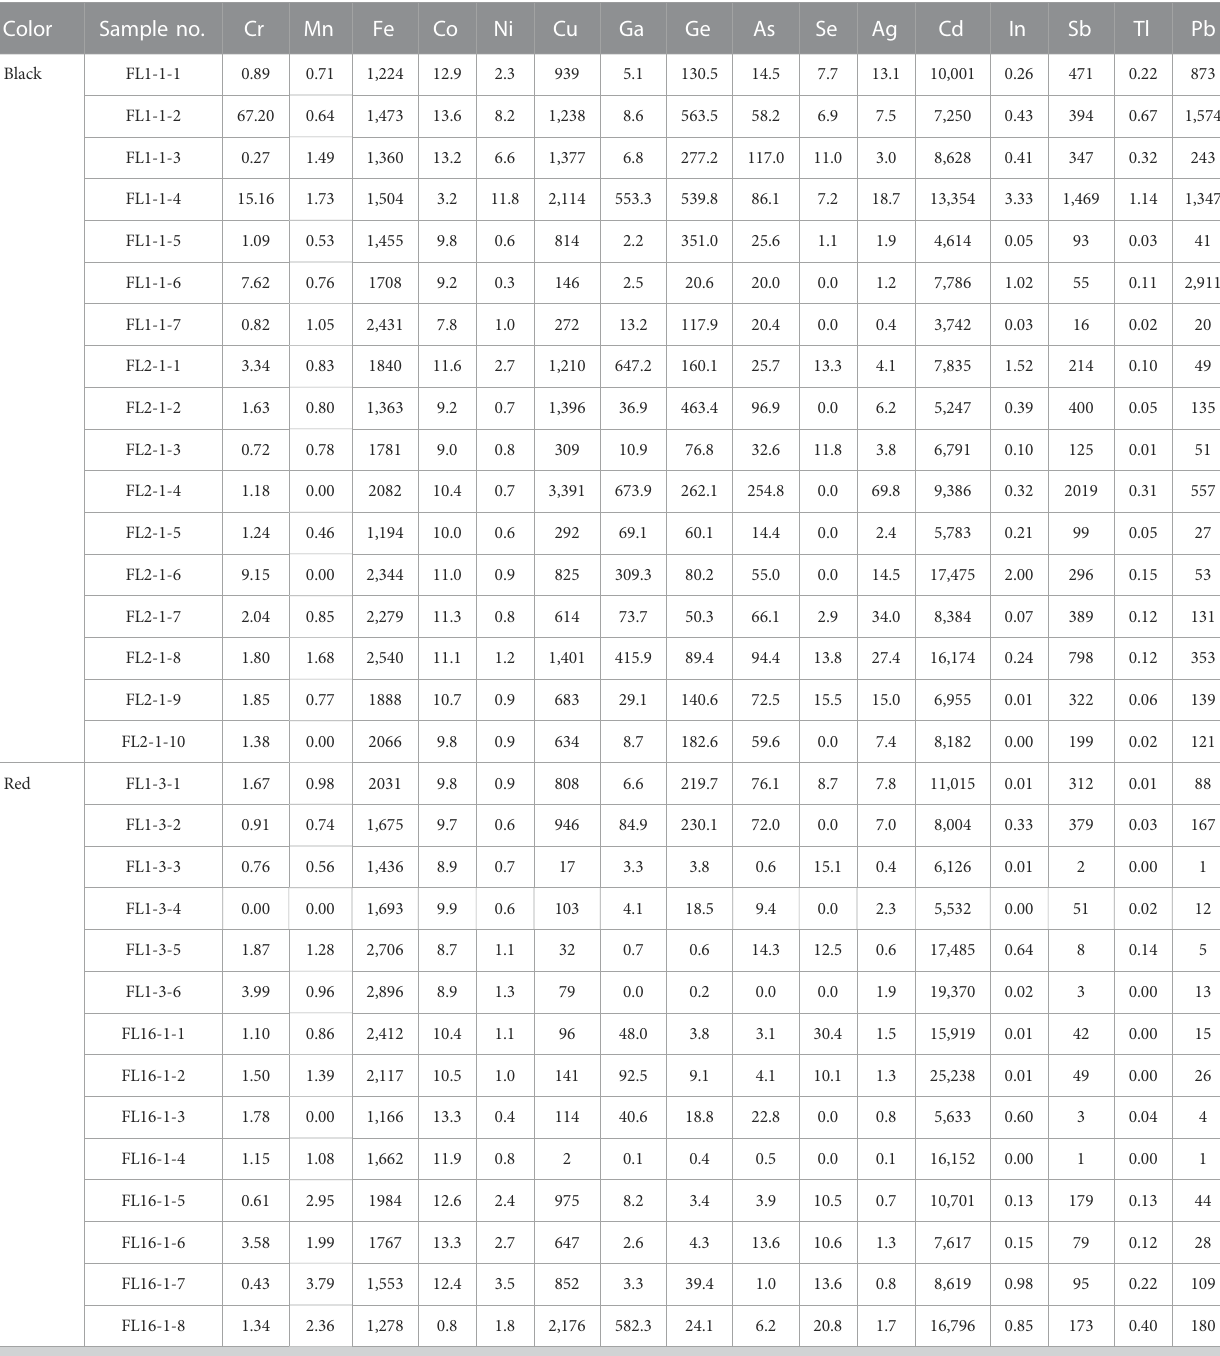
TABLE 1 Summary of LA-ICP-MS sphalerites trace element concentration (ppm) in the Fuli Pb-Zn deposit. Color Sample